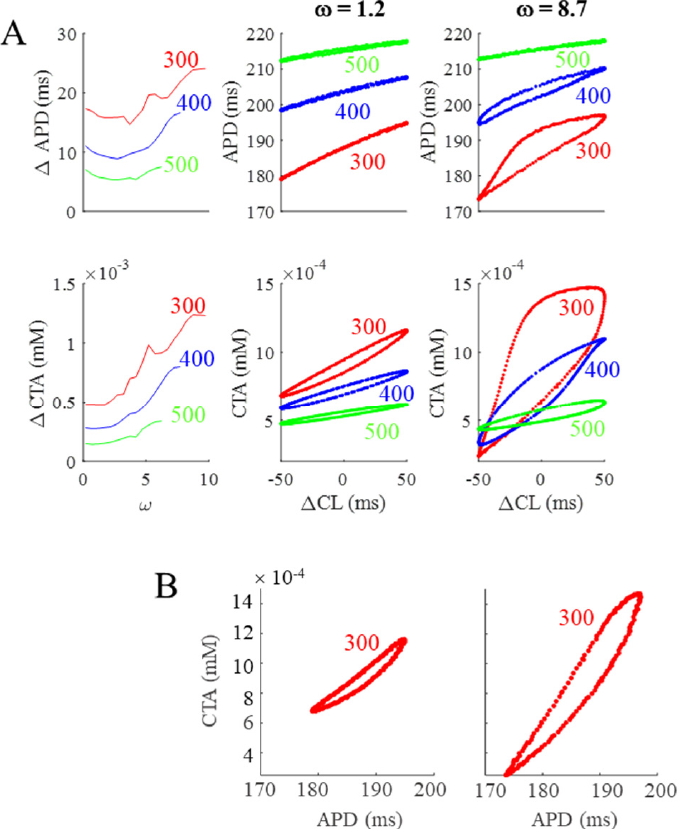
Figure 4. Summary of BCL and ω dependence of the OR model. ( A ). First column: ω dependence of APD and CTA oscillation amplitudes ( ∆ APD and ∆ CTA) under SVP according to Equation (1) at three pacing BCLs (values in ms reported in color). Second column: btb-ER representations of the same APD (top) and CTA (bottom) sequences for a low ω value. Third column: Same for a high ω value. ( B ): Phase plots CTA vs. APD of the same sequences reported in panel A in red. The one at ω = 8.7 is the same also reported in Figure 3C.